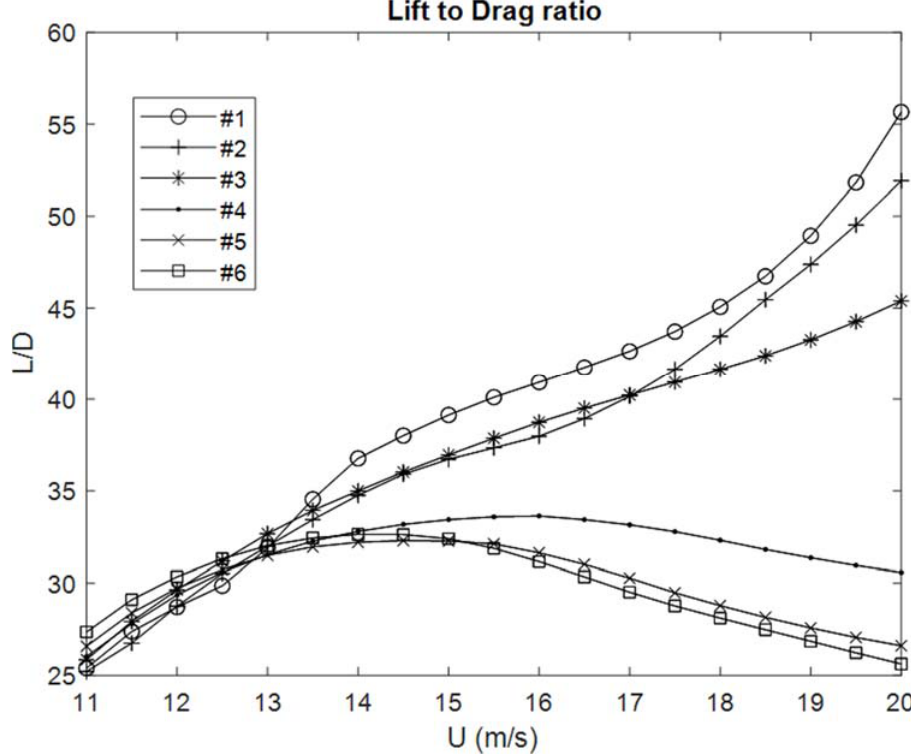
Figure 12. Estimated L/D variation with speed for the main configurations.